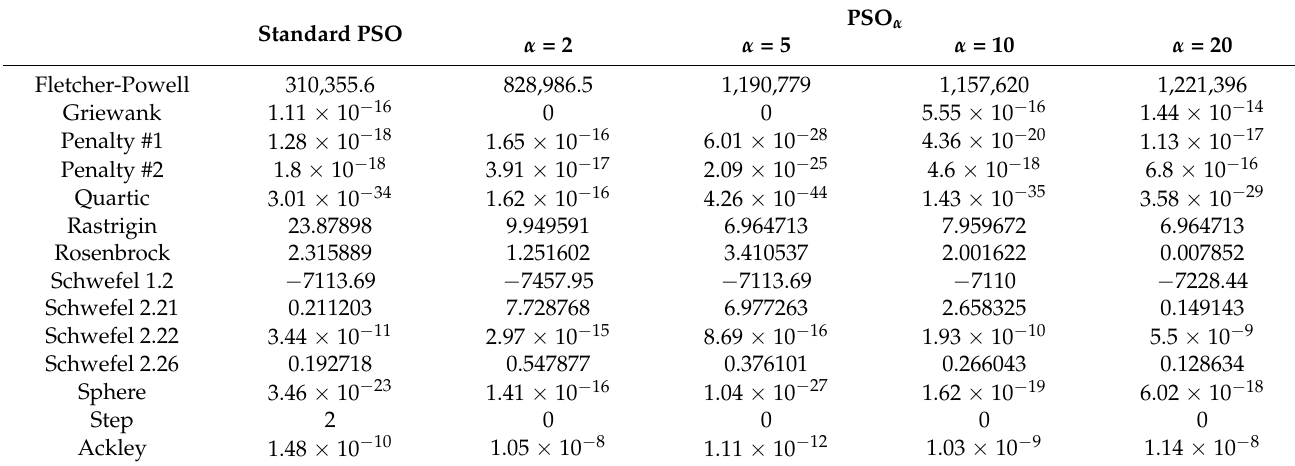
Table 2. Best fitness values of the cost functions for 50 simulations.